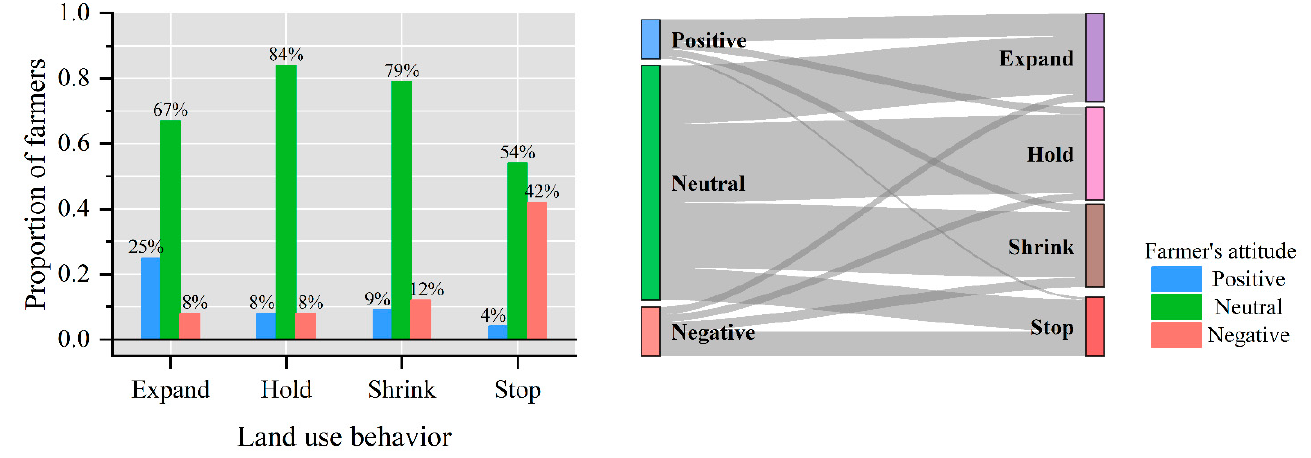
Figure 8. Land use behavior of different types of farmers.